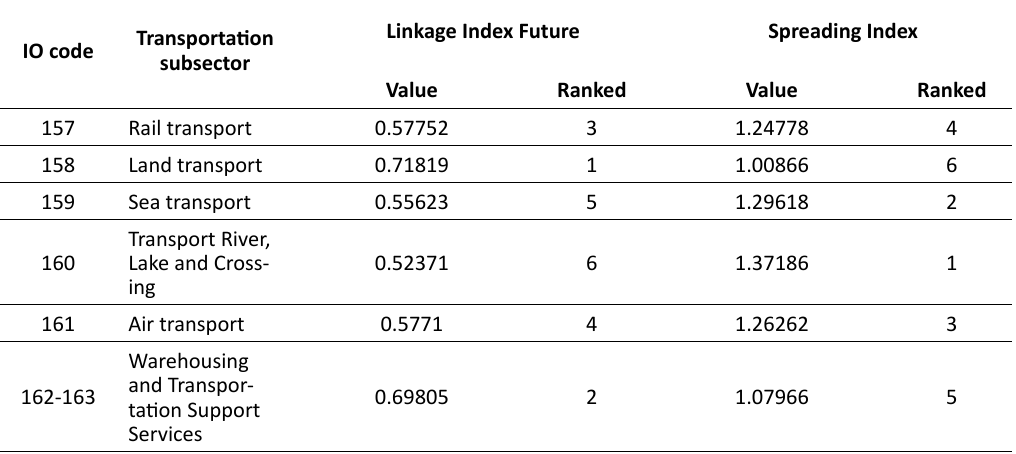
Table 3: Linkage Index FutureTransportation Subsector Indonesia Year